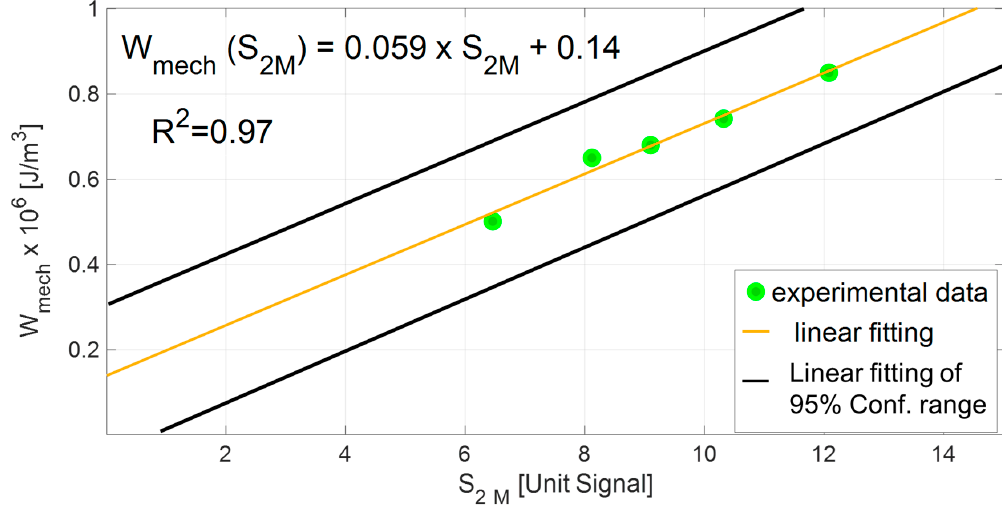
Figure 9. Relation between W mech and S 2 _M .